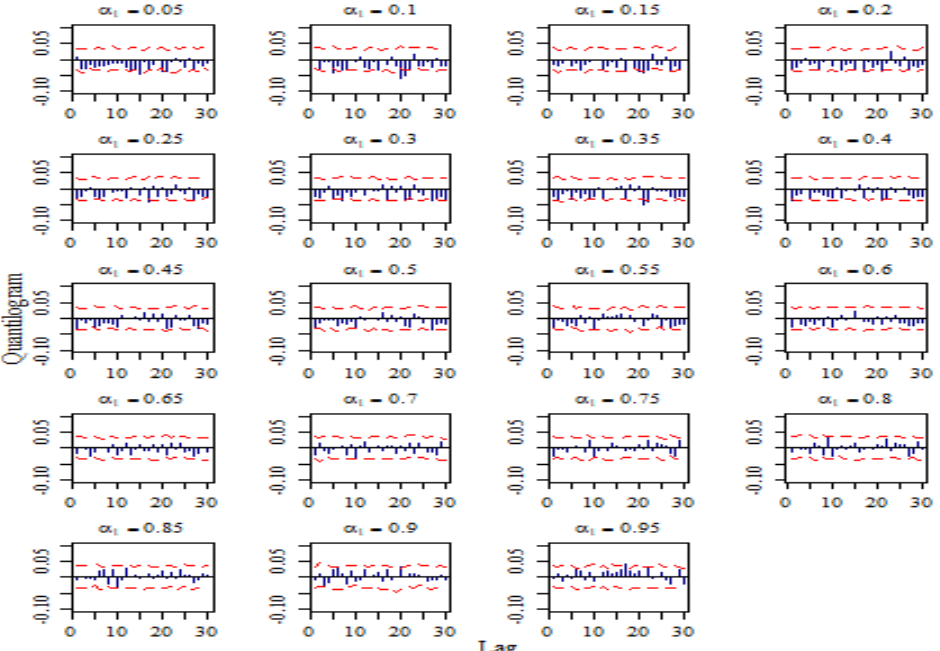
Figure 11. Sample cross-quantilograms for OVX returns in the median quantile, i.e., q 2 ( α 2 ) for α 2 = 0.5, to capture directional predictability from OVX to WTI returns. See notes to Figure 3.